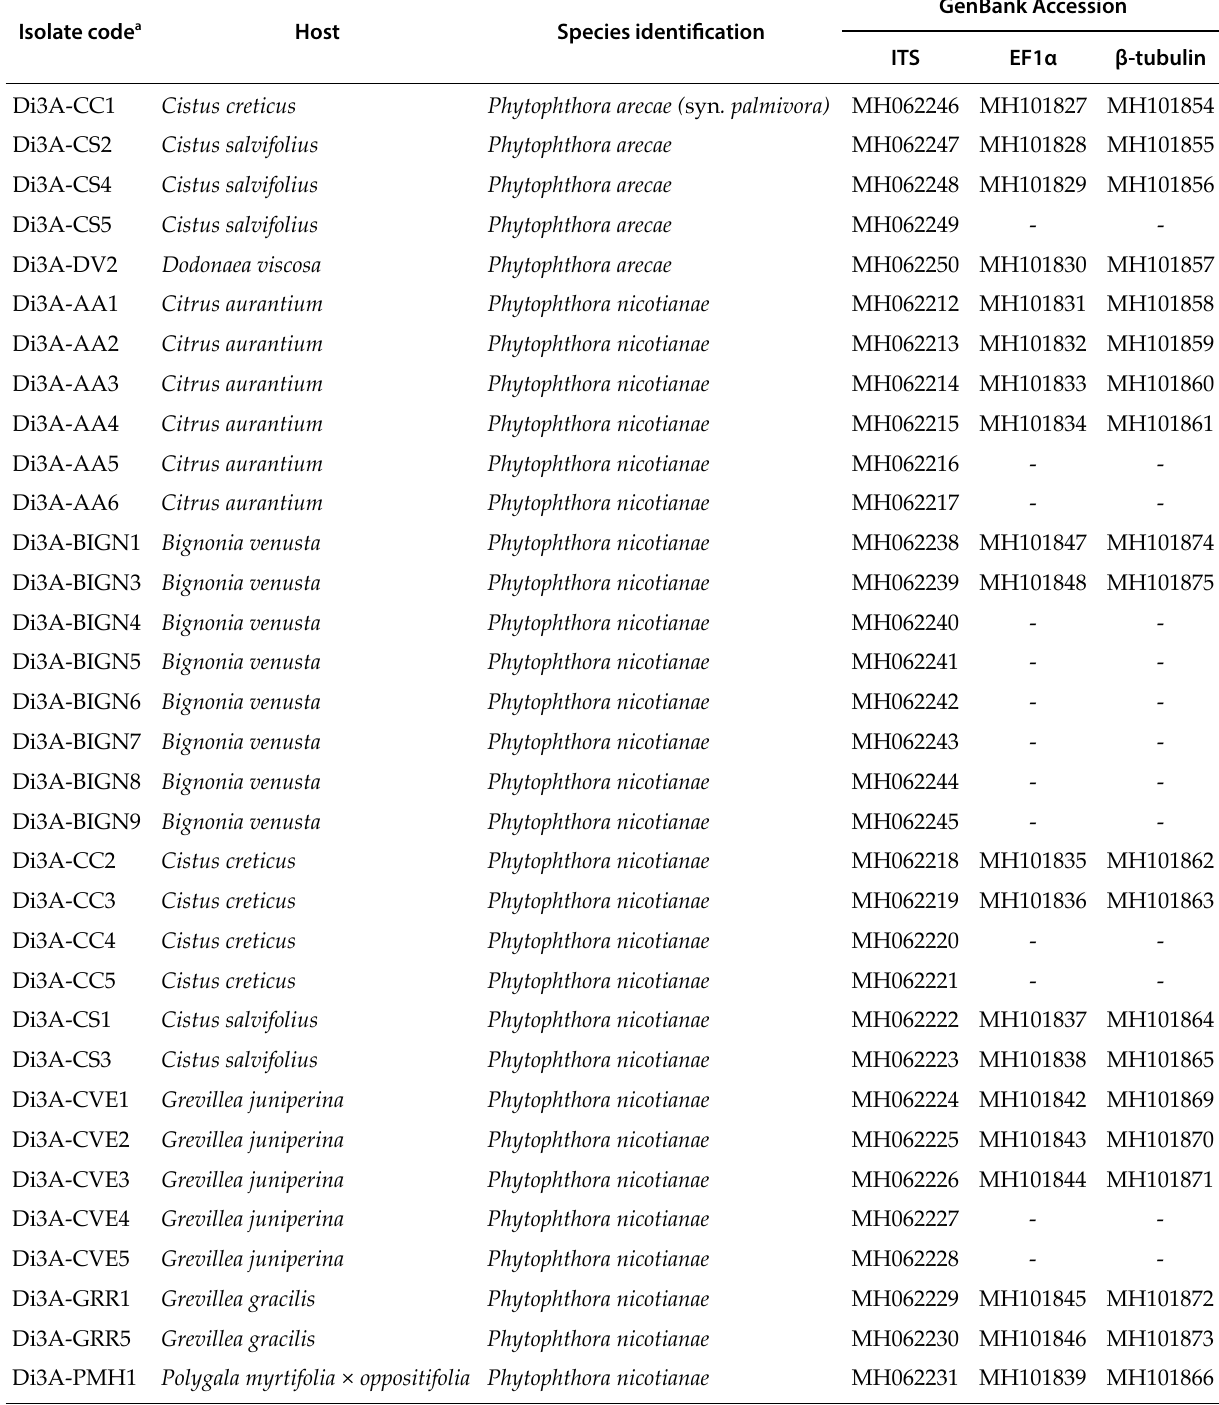
Table 2. Identity and Genbank accession numbers of Phytophthora spp. isolates collected from ornamental plants in Italy. Isolate code